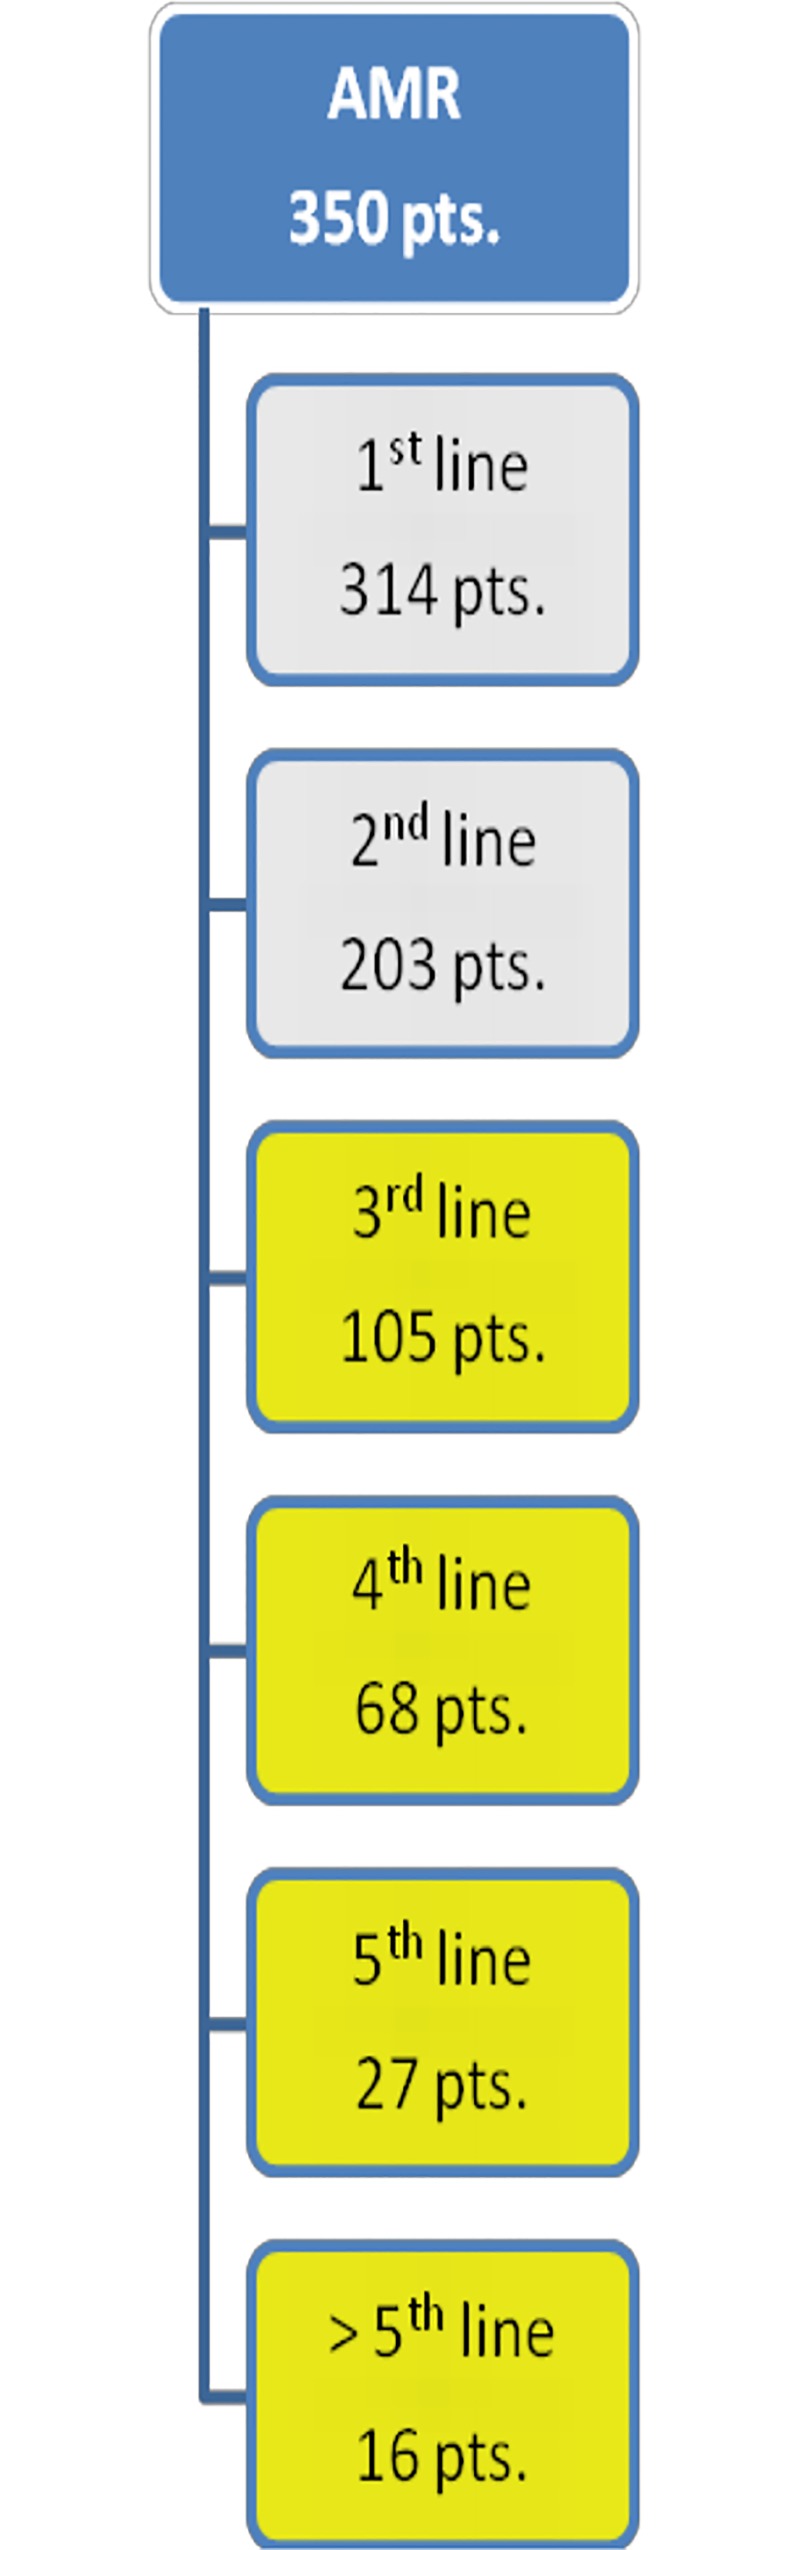
Patients and treatment lines.illustrates the distribution of treatment lines and patients (pts.) documented in the Austrian Myeloma Registry (AMR). Patients who had received at least 3 lines of therapy were included in the analysis (yellow boxes).